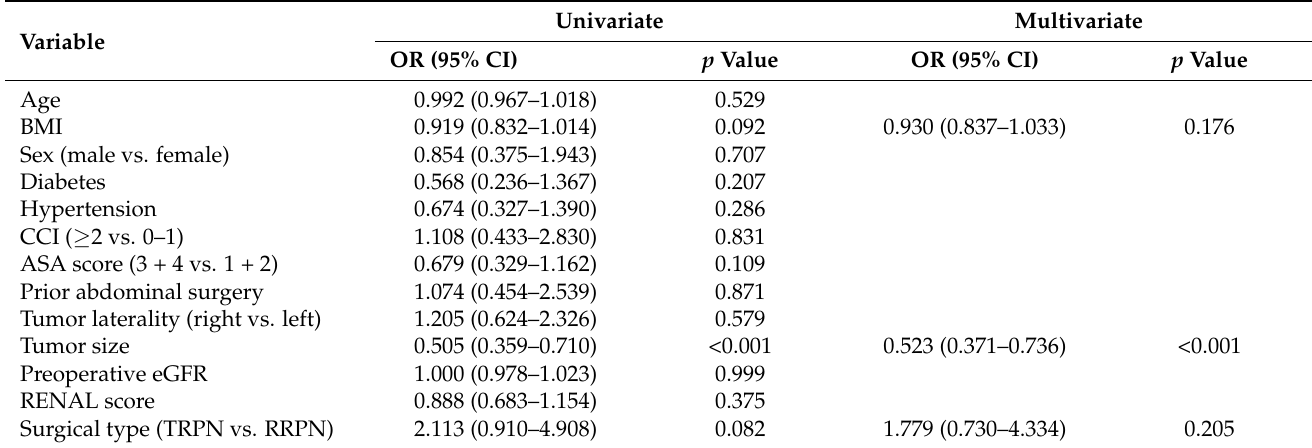
Table 5. Univariable and multivariable analysis for factors associated with achieving